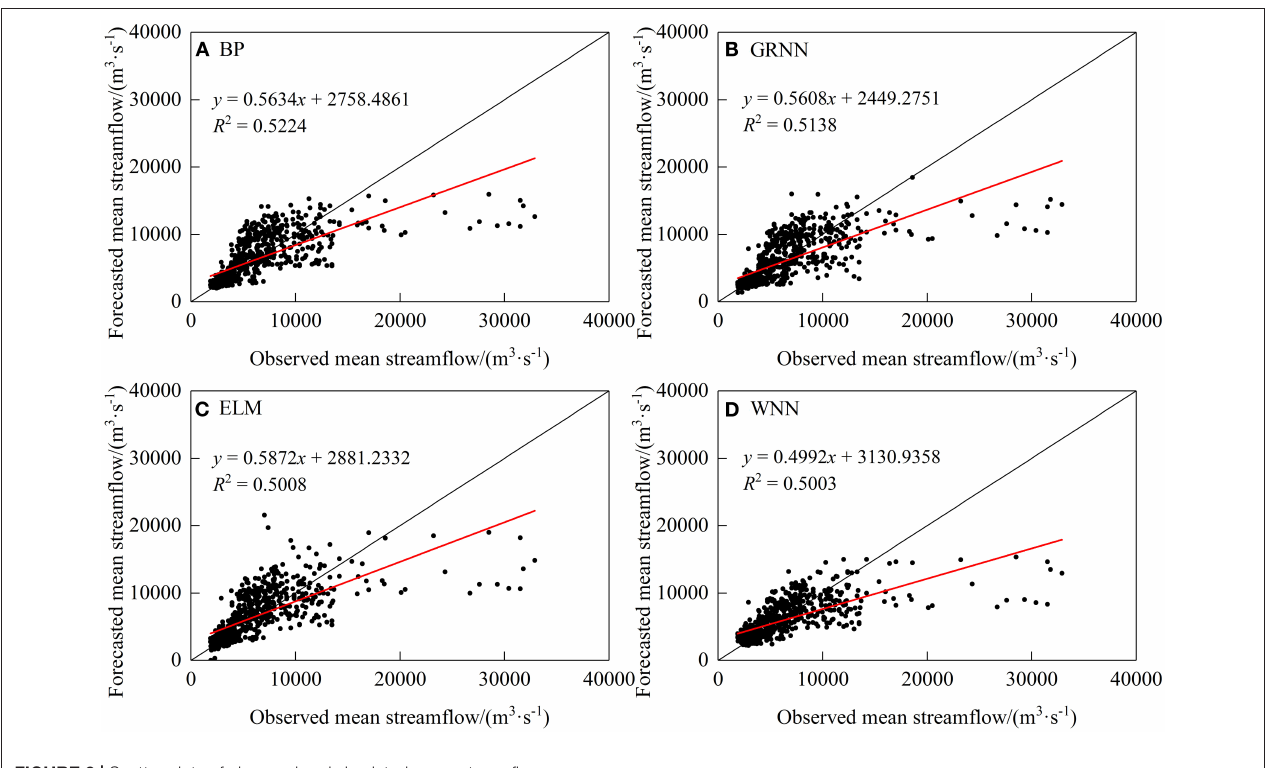
FIGURE 2 | Scatter plots of observed and simulated mean streamflow.